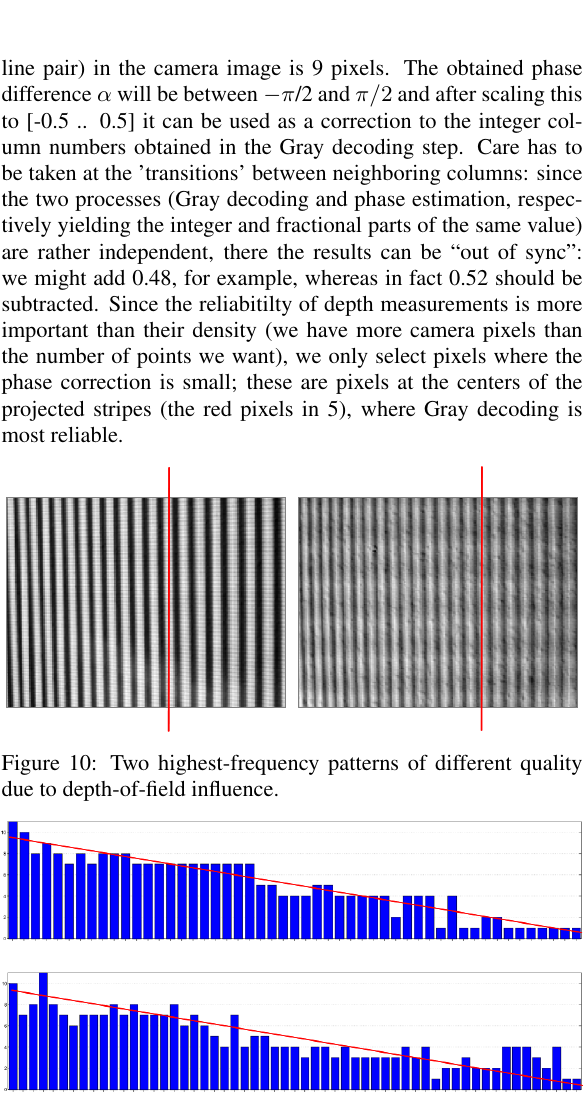
Figure 11: Phase estimate accuracy (see text).